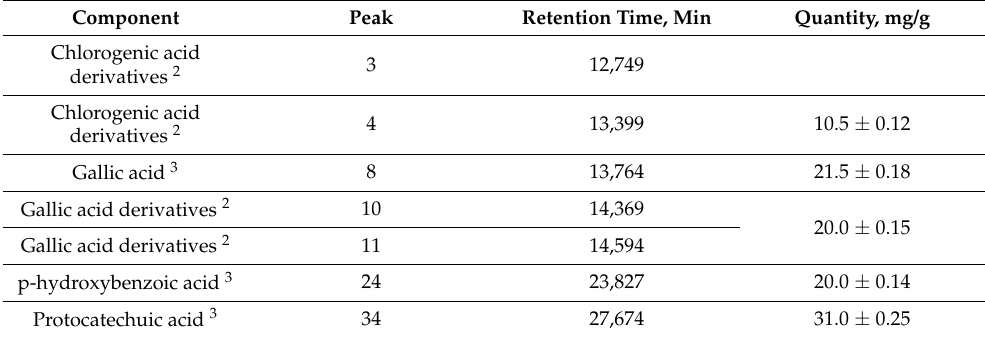
Figure 4. HPLC of the main polyphenols in Amelanchier ovalis : peak 8 is gallic acid; peaks 10 and 11 are gallic acid derivatives (277 nm). Table 1. Phenolic acid (mg/g) 1 in Amelanchier ovalis berry extract.